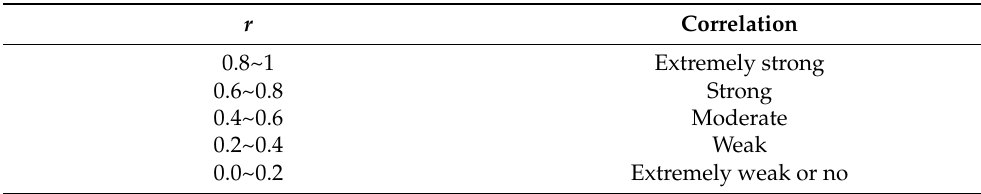
Table 1. Classification of correlation